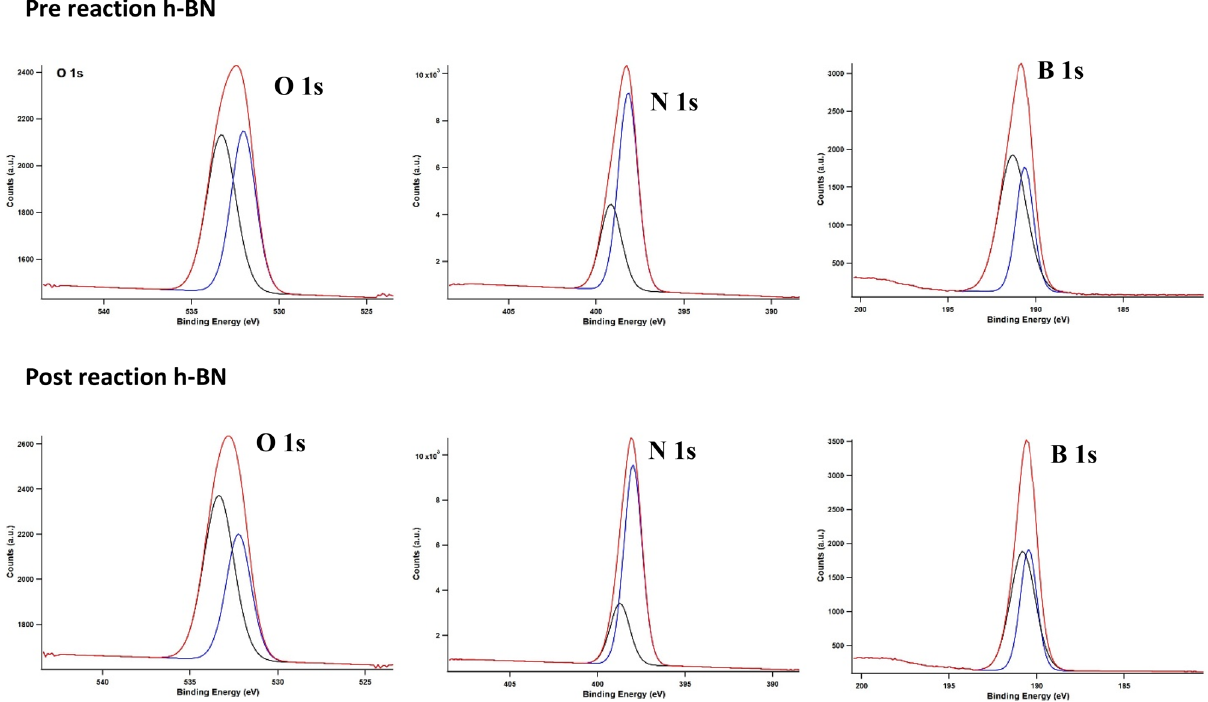
Figure 8. X-ray photoelectron spectroscopic (XPS) analysis of pre and post-reaction for h -BN obtained with Physical Electronics Quantum 200 scanning ESCA microprobe with Al Kα radiation (29.35 eV pass energy, charge compensated with adventitious carbon 284.8